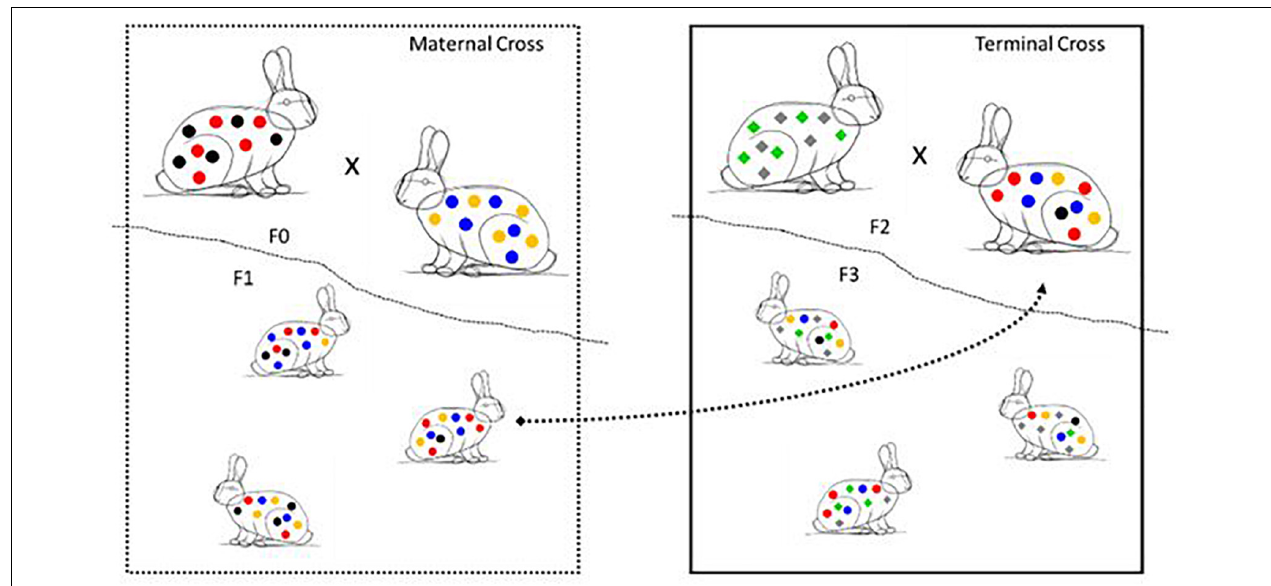
FIGURE 3 | Schematic representation of crossing specialized maternal lines (generation F0) for further crossing with a paternal line (generation F2). Genetic diversity is represented by colored shapes (circles for maternal lines and diamonds for the paternal